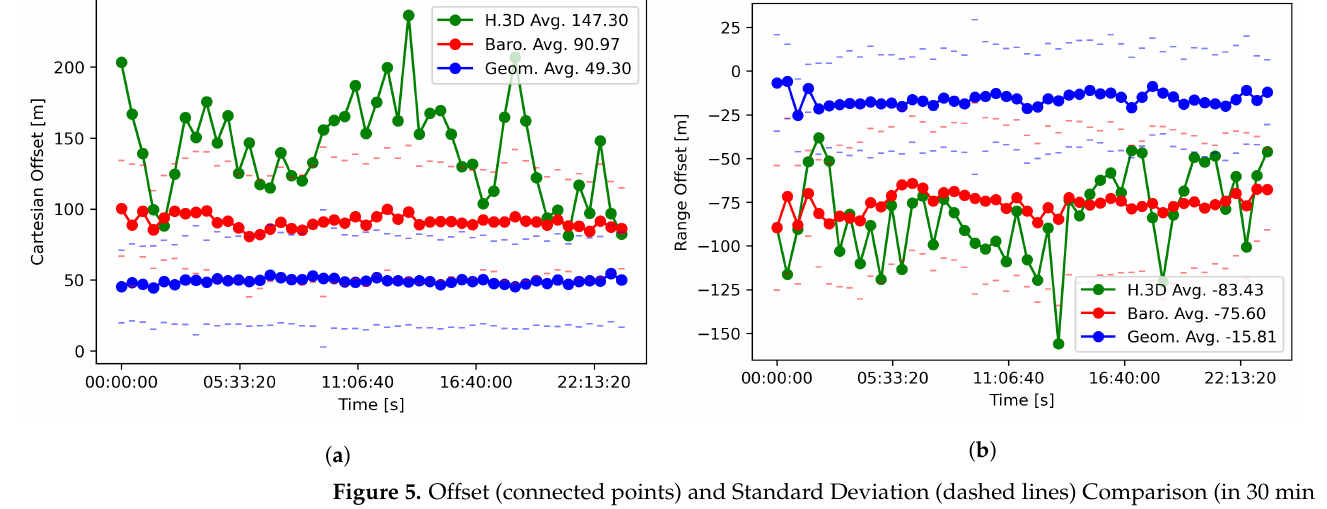
Figure 5. Offset (connected points) and Standard Deviation (dashed lines) Comparison (in 30 min Intervals). ( a ) Cartesian Offsets. ( b ) Ground Range Offsets.